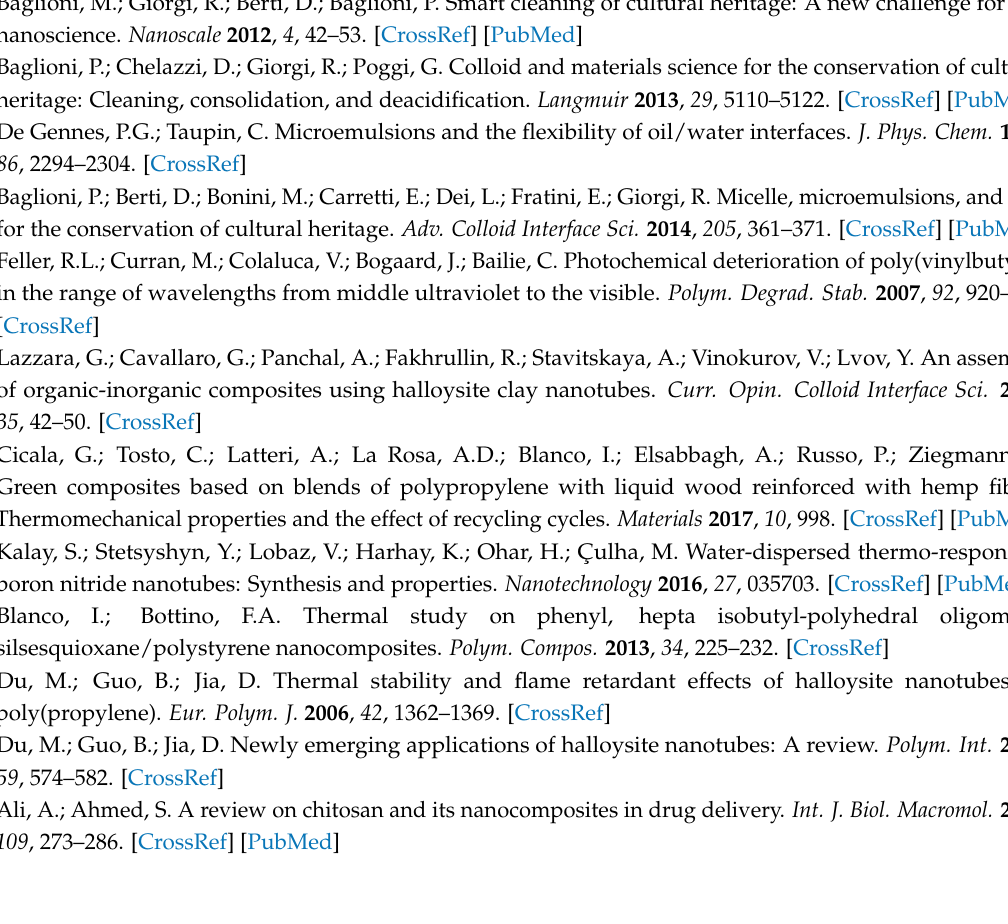
Figure S1: FTIR spectra of extracts after first (yellow), second (grey) and third (pink) cleaning cycle. Figure S2: SEM images of Halloysite